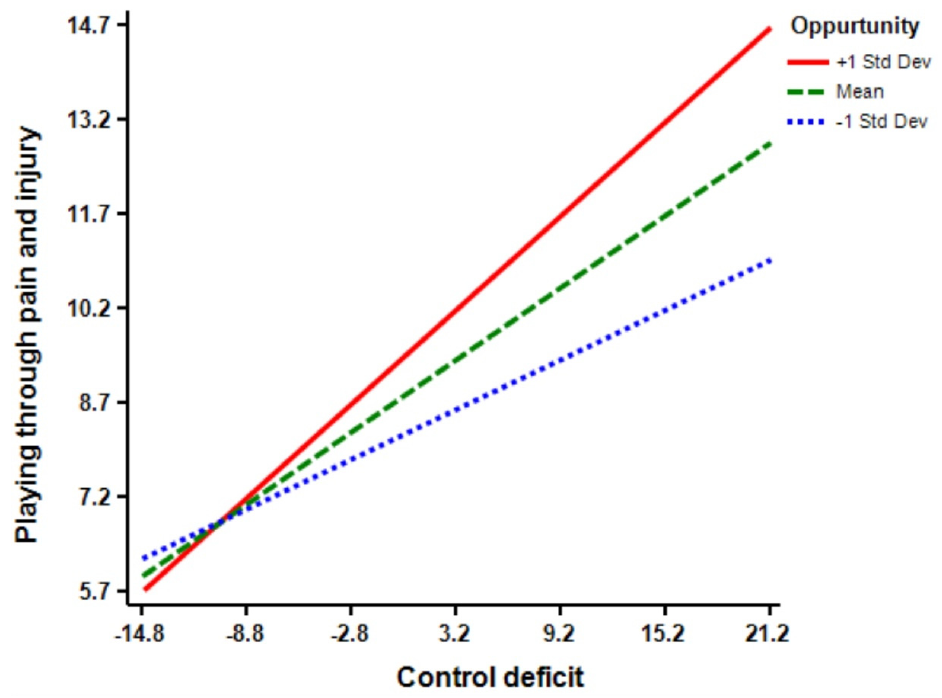
Figure 6. Opportunity by control balance deficit interaction.